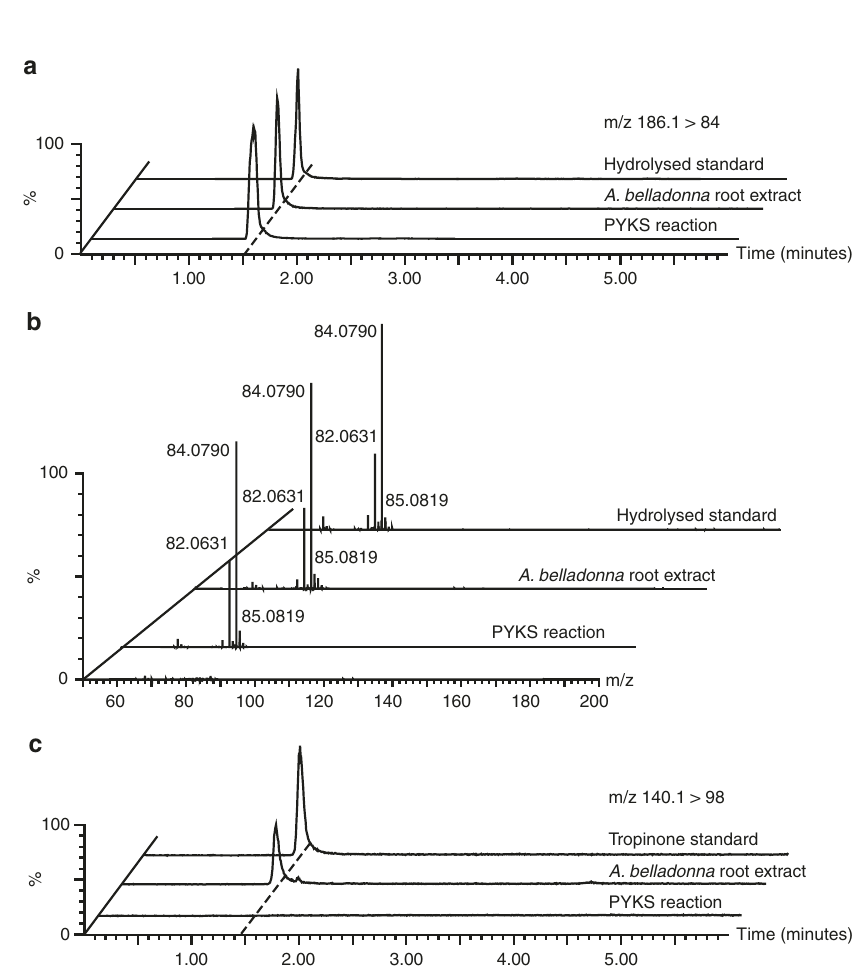
Fig. 2 AbPYKS catalysis generates 4-(1-methyl-2-pyrrolidinyl)-3-oxobutanoic acid. a Extracted ion LC/MS/MS multiple reaction monitoring (MRM) chromatograms in positive-ion mode ( m/z 186.1 > 84) for the 4-(1-methyl-2-pyrrolidinyl)-3-oxobutanoic acid ( 5 ) ion from a hydrolyzed 4-(1-methyl-2- pyrrolidinyl)-3-oxobutanoic acid methyl ester standard, a root extract of a 5-week-old A. belladonna plant, and a representative AbPYKS enzyme reaction. b Positive-ion mode product ion MS/MS spectra for m/z 186 of 4-(1-methyl-2-pyrrolidinyl)-3-oxobutanoic acid ( 5 ) in a hydrolyzed 4-(1-methyl-2- pyrrolidinyl)-3-oxobutanoic acid methyl ester standard, a root extract of a 5-week-old A. belladonna plant, and a representative AbPYKS enzyme reaction using data-independent SONAR MS/MS scanning as described in the Methods section. c Extracted ion LC/MS/MS chromatograms in positive-ion mode ( m/z 140.1 > 98) detecting tropinone ( 7 ) from an authentic standard, a root extract of a 5-week-old A. belladonna plant, and a representative AbPYKS enzyme